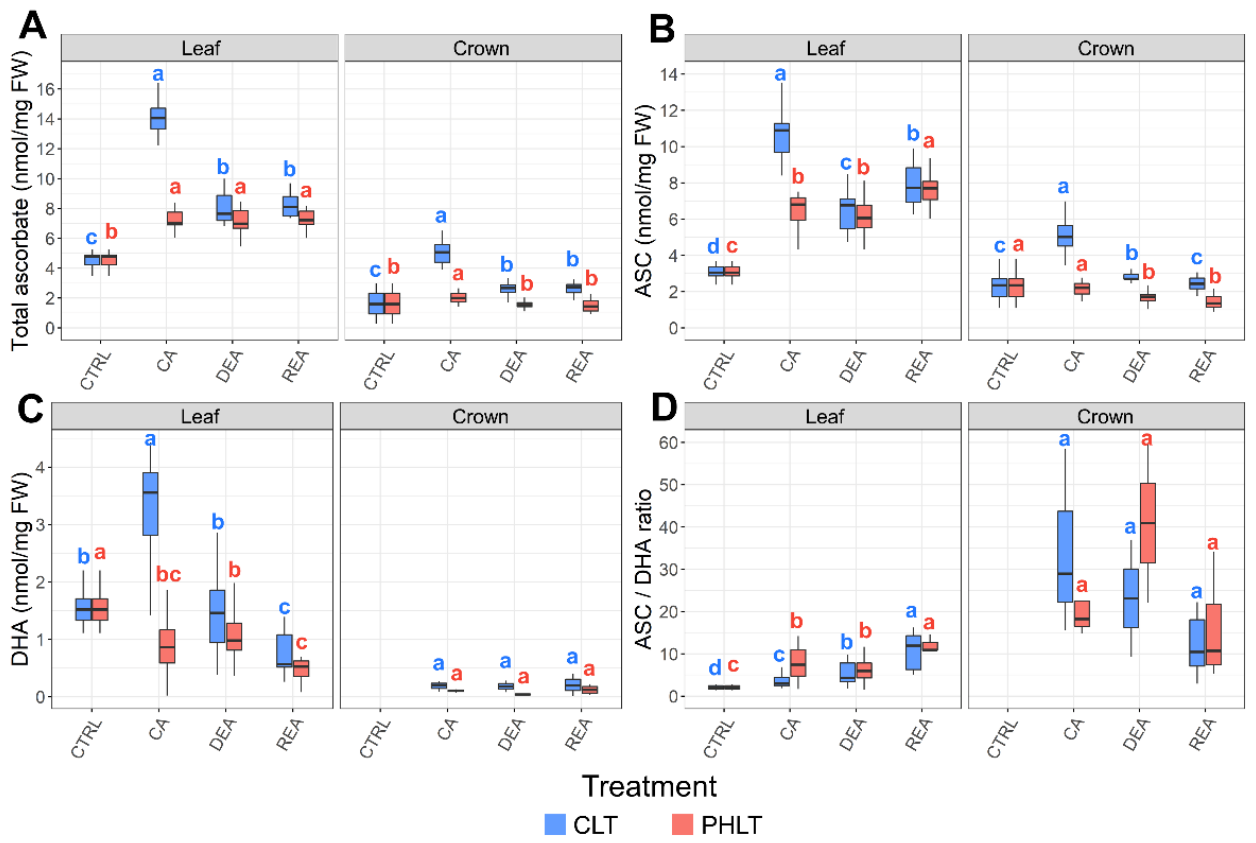
Figure 2. The effect of cold acclimation (CA), deacclimation (DEA), and reacclimation (REA) on ascorbate accumulation in leaf and crown tissues of winter wheat under two low-temperature treatments. The dynamics of total ascorbate ( A ), reduced ascorbate (ASC) ( B ), oxidised ascorbate (DHA) ( C ), and the ratio of reduced to oxidized ascorbate (ASC/DHA) ( D ) are provided. The letters above the boxplots indicate significant ( p < 0.05) differences between stages of acclimation within each tissue type and treatment group. CLT — constant low-temperature treatment during CA; PHLT — prolonged higher low-temperature treatment during CA. The control (CTRL) sampling point pre- ceded the acclimation treatments; therefore, the concentrations at this stage are identical. The con- centration of DHA in crown tissue at the CTRL sampling point was below the detection threshold.